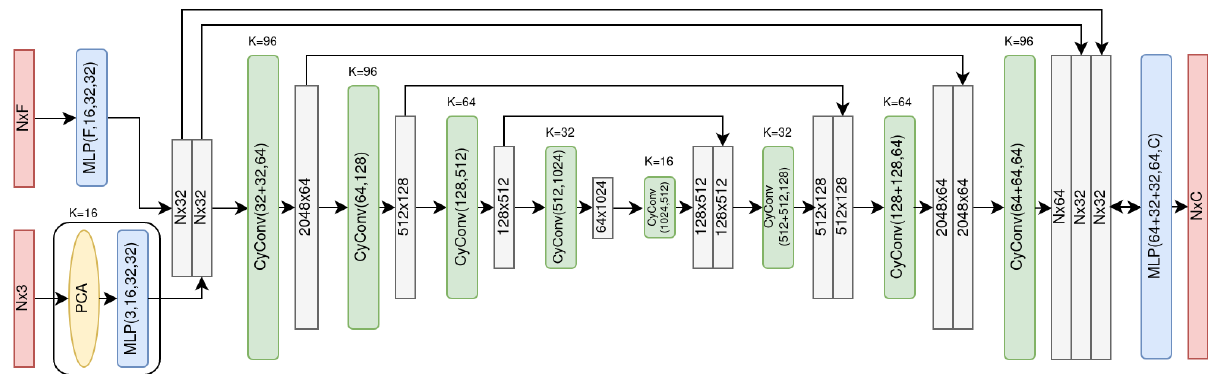
Figure 6. Structure of the encoder-decoder network with the Cylindrical convolutions, the MLP and PCA modules. Each CyConv layer also takes as input the downsampled point cloud along with the previous layer’s features in order to perform the spatial pooling. K denotes the numbers of searched neighbors per input point at each layer